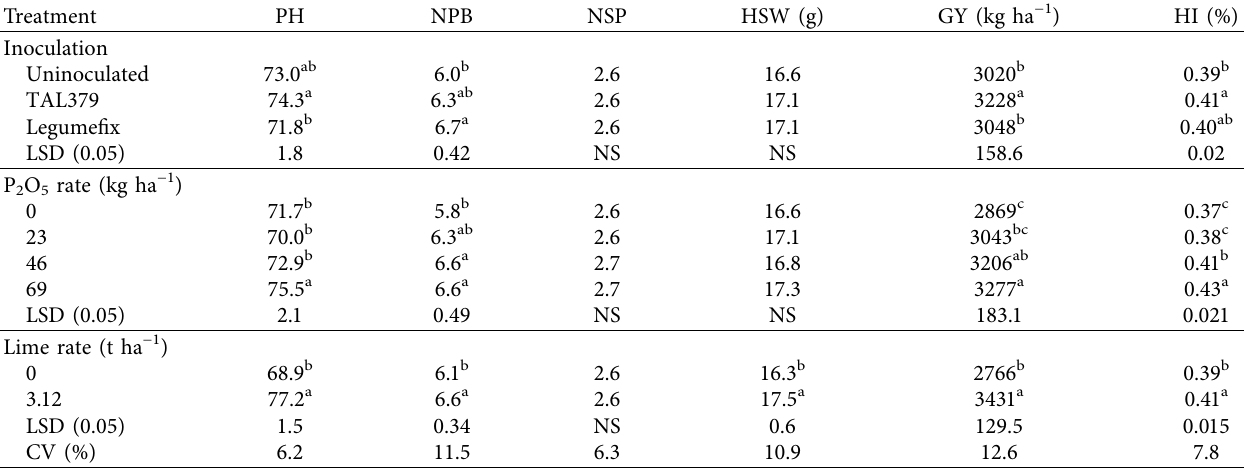
Table 4: Main effects of Bradyrhizobium , lime, and phosphorus fertilizer rates on grain yield and harvest index of soybean.